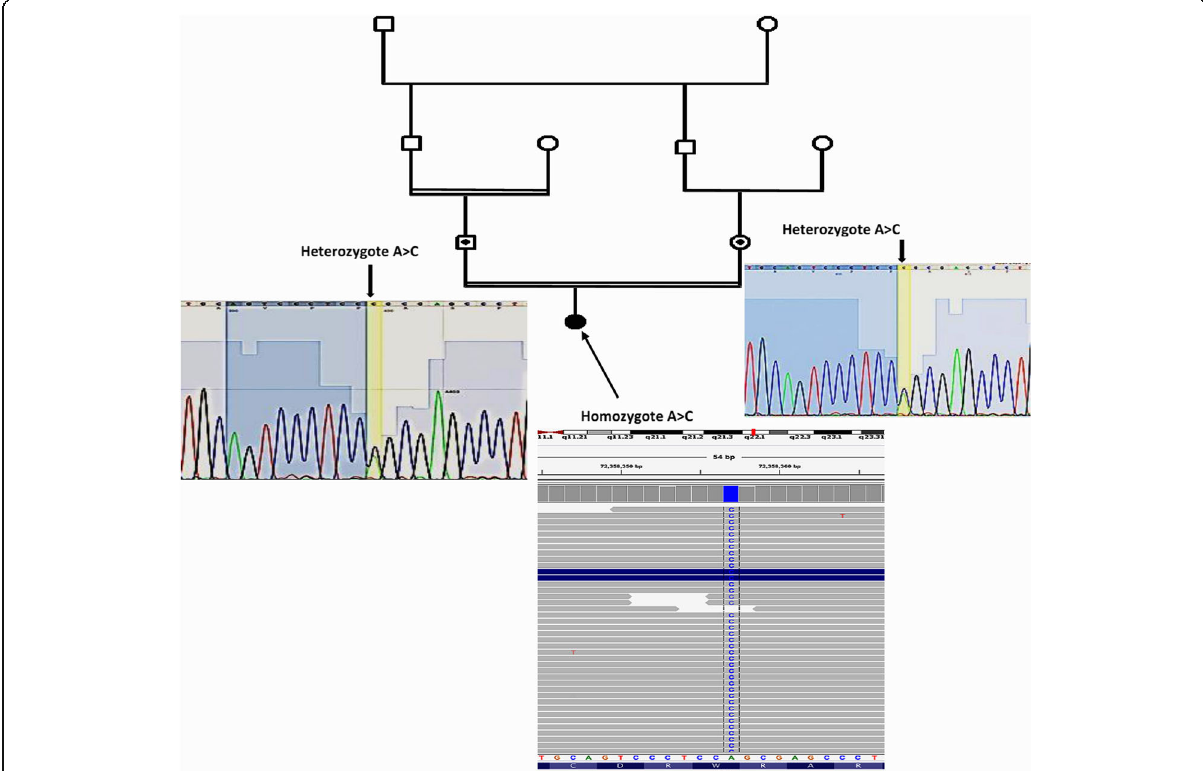
Fig. 2 The proband is a boy with hepatitis and pancytopnea and his parents has consanguineous marriage. NGS results indicate homozygous mutation in PRF1 gene in the proband as visualized using Integrative Genome Viewer (IGV) and using Sanger sequencing presence of the identified heterozygous mutation in PRF1 gene was confirmed in the parents